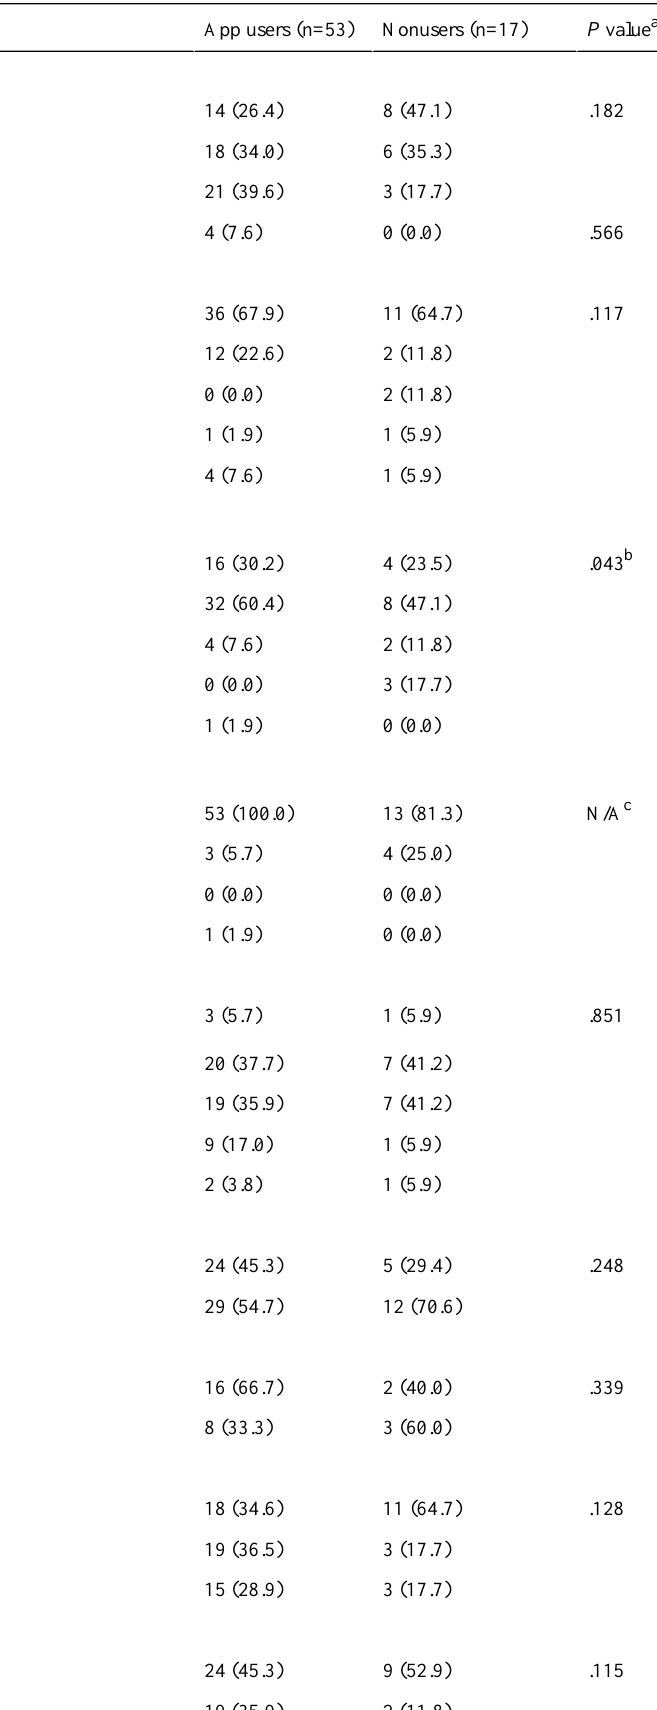
Table 1. Sample sociodemographics